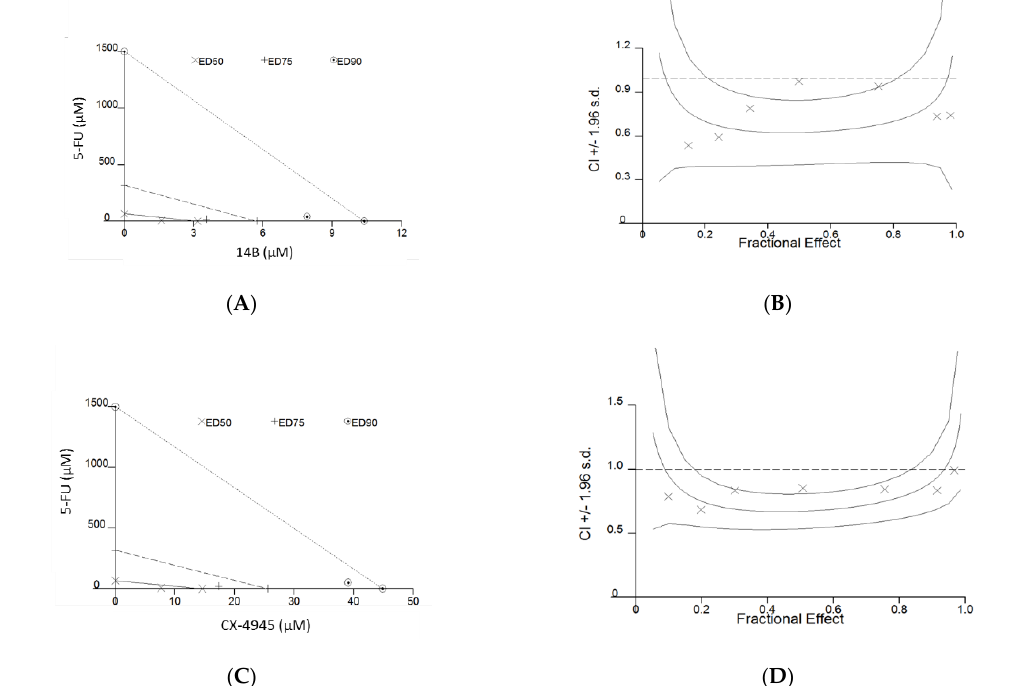
Figure 1. Synergistic interaction of 5-fluorouracil (5-FU) with CK2 inhibitors, i.e., 14B or CX-4945, in inhibition of viability of the MDA-MB-231 cell line. ( A , C ) Representative CalcuSyn software-simulated isobolograms. ( B , D ) Fraction affected-combination index (Fa-CI) curves for the respect combinations of 5-FU with either 14B or CX-4945 after 72 h of treatment, generated after fitting Fa obtained from the MTT assay.